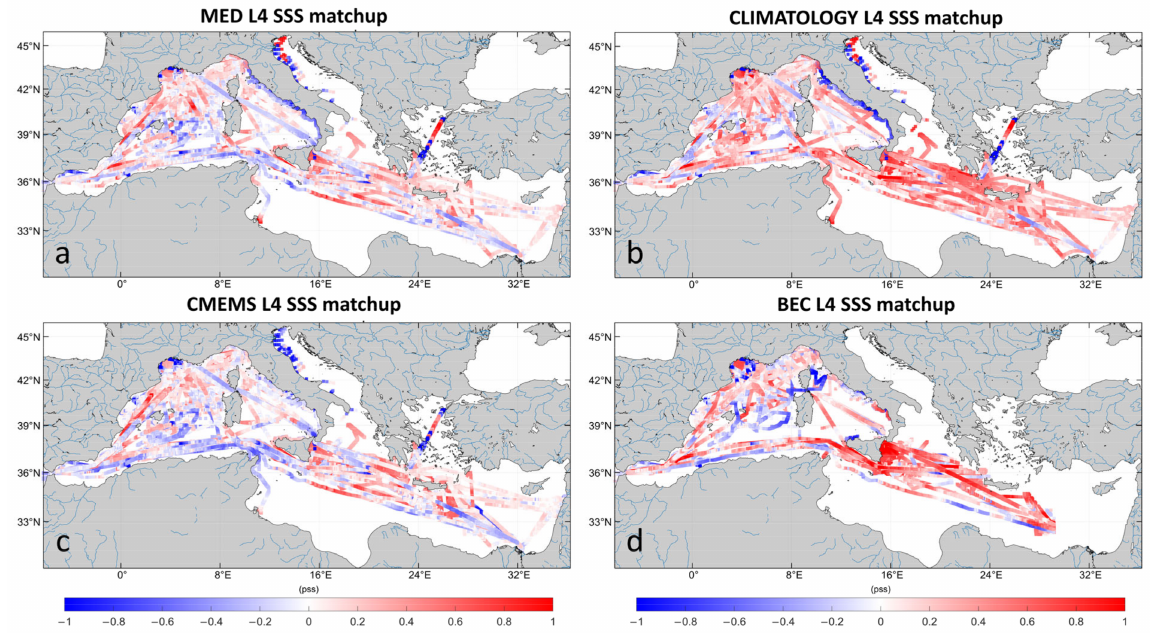
Figure 5. Spatial distribution of the validation matchups between the four L4 SSS datasets and in situ observations. The colour of the dots refers to the biases between in situ estimates and the corresponding values extracted from new Med L4 SSS values ( a ); in situ Climatology L4 SSS ( b ); CMEMS L4 SSS and BEC L4 SSS (( c , d ), respectively) products. The validation of the New Med